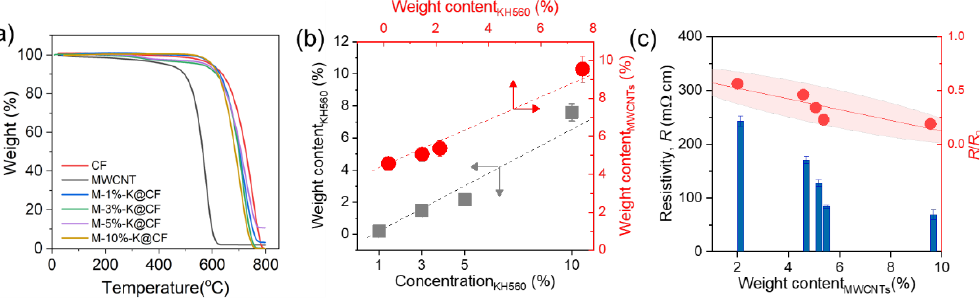
Figure 4. ( a ) Weight fraction as a function of temperature for CFs with and without MWCNTs, from which the weight fraction of KH560 and MWCNTs in ( b ) is estimated. The electrical resistivity R (blue columns) as a function of MWCNTs is shown in ( c ). The arrows indicate the data belong to the corresponding axis and the dotted lines are guides to the eye. The red area in ( c ) denotes the 95% confident ellipse (mean) of R/R 0 (red square).